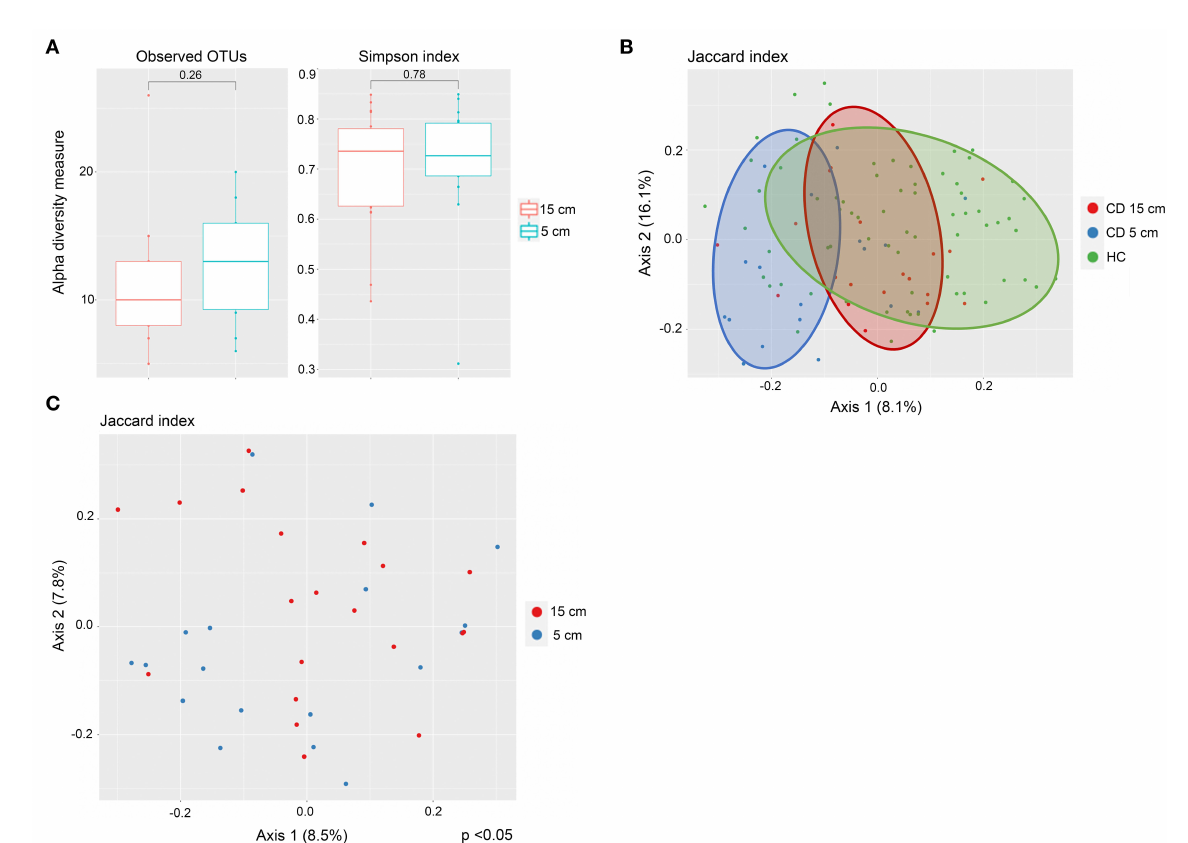
FIGURE3 Fungal mycobiota in inflamed and proximally non-inflamed ileal mucosa in Crohn’s disease (CD) patients without upper CD involvement ( n = 20). Biopsies sampled at inflamed 5-cm and non-inflamed 15-cm proximal to the ileocecal valve or ileocolic anastomosis. (A) No differences in alpha diversity, according to observed operational taxonomic units (OTUs) (left) and Simpson index (right), boxplots colored according to biopsy location (inflamed 5cm = blue, non-inflamed 15cm = red). (B) Mycobiota composition in inflamed terminal ileum (blue) and proximally non-inflamed ileum (red) of CD patients ( n = 20) and in healthy controls (HC) (green) ( n = 40). Principal coordinates analysis of Jaccard index with samples colored according to disease status (CD and HC) and ileal location. The fraction of diversity captured by the coordinate is given in percentage on axes 1 and 2. (C) Different mycobiota composition in inflamed (blue) and proximally non-inflamed ileum (red) according to beta diversity. Principal coordinates analysis of Jaccard index with samples colored according to ileal location. The fraction of diversity captured by the coordinate is given in percentage on axes 1 and 2. Groups were compared using the Permanova